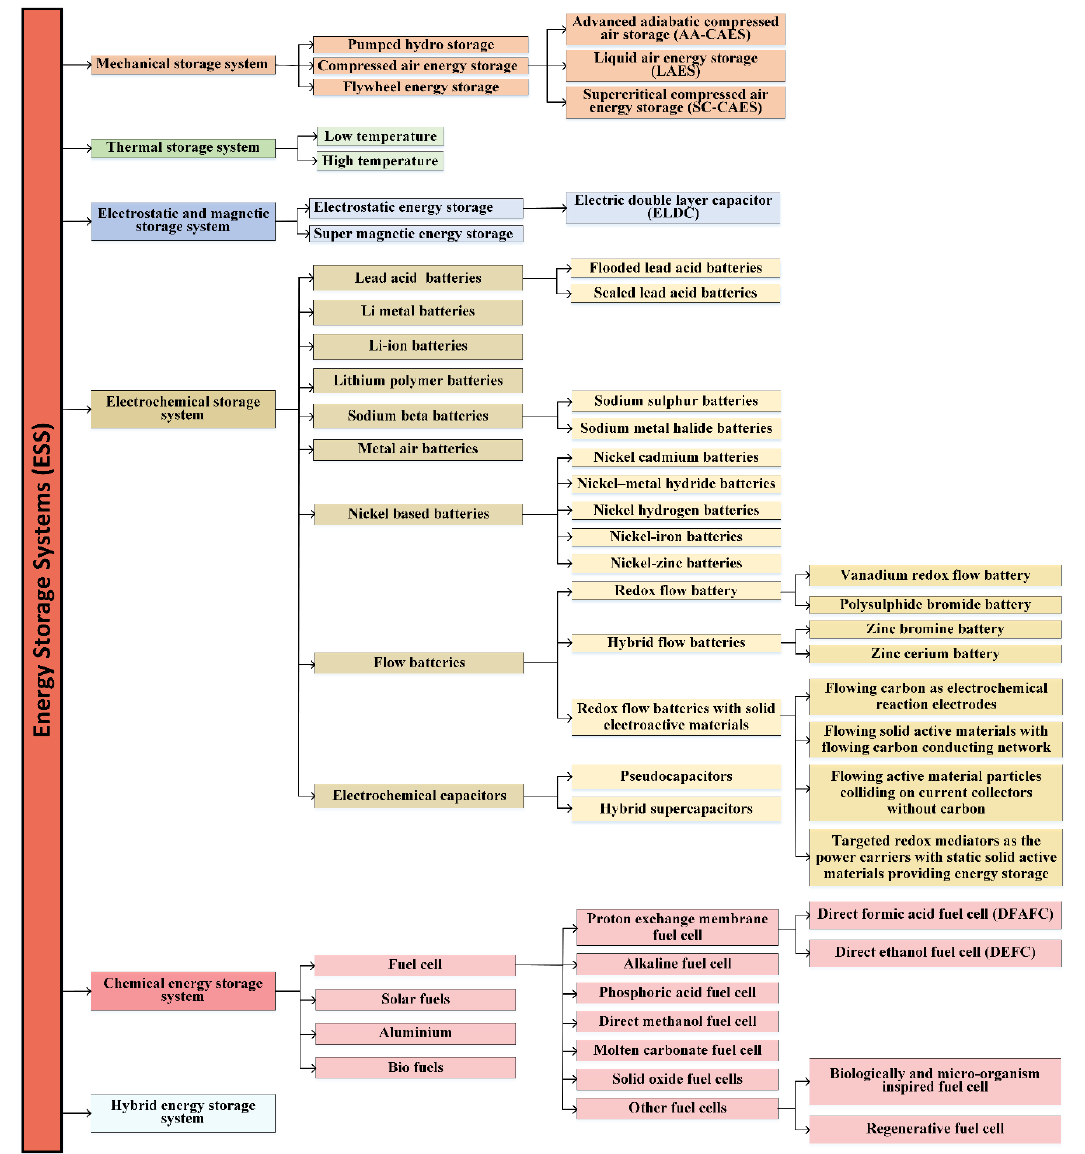
Figure 3. Classification of ESSs as described in this paper.